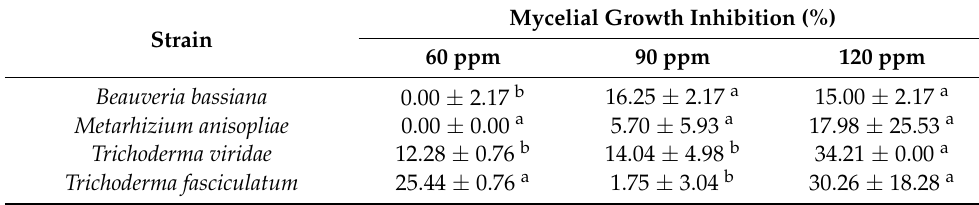
Table 2. Percentage inhibition of radial growth of beneficial fungi strains at different silver nanoparti- cles concentration rates *.